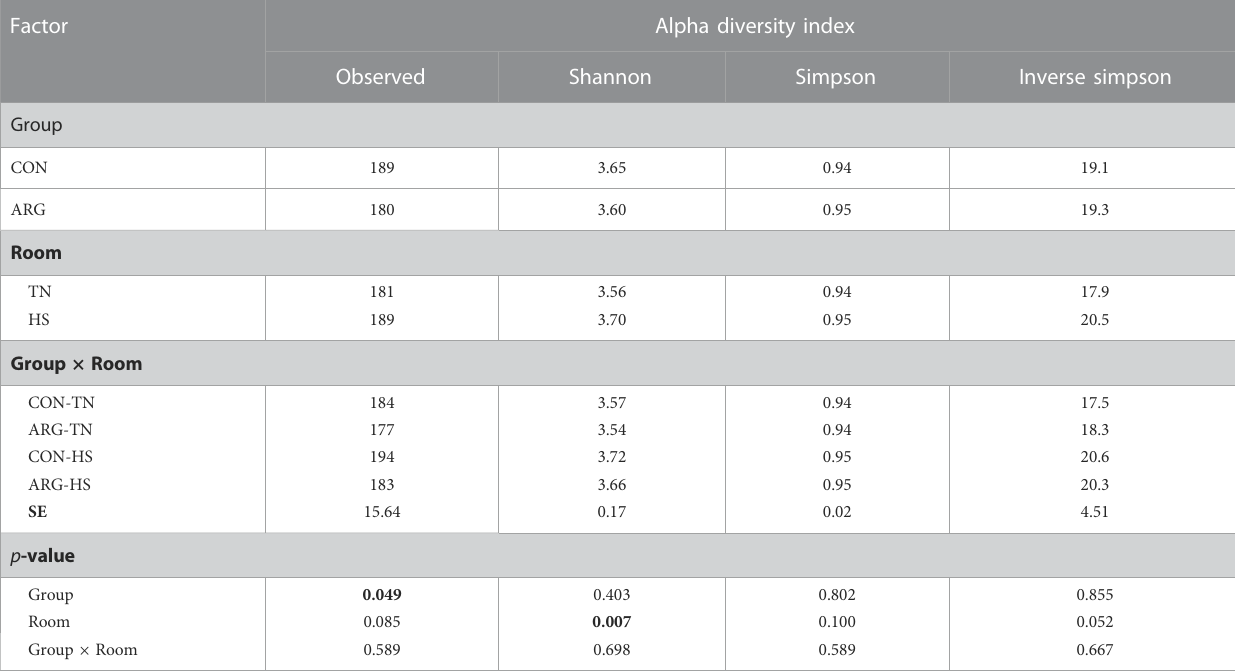
TABLE 4 Alpha diversity indices of the cecal content of CON and ARG birds in the two rooms at